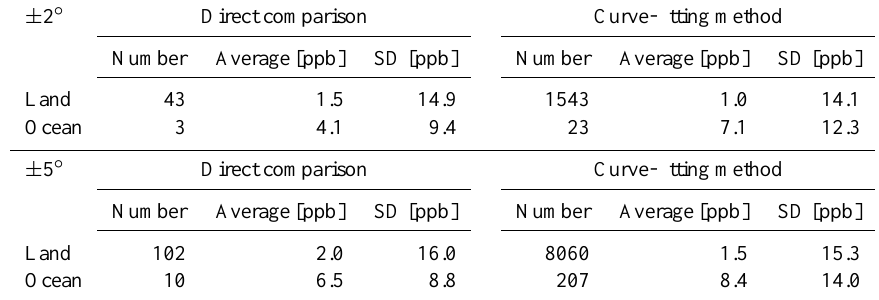
Table 6. Differences between GOSAT XCH 4 and aircraft-based XCH 4 for all sites from the direct comparison and curve-fitting